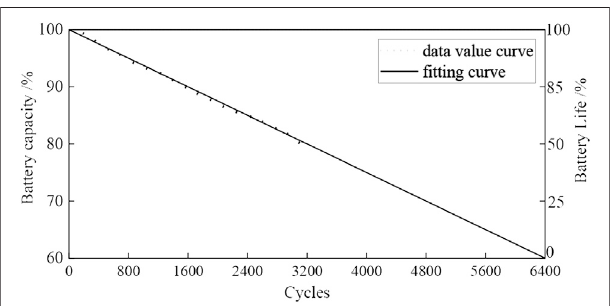
FIGURE 2 | Relationship between cycle number and